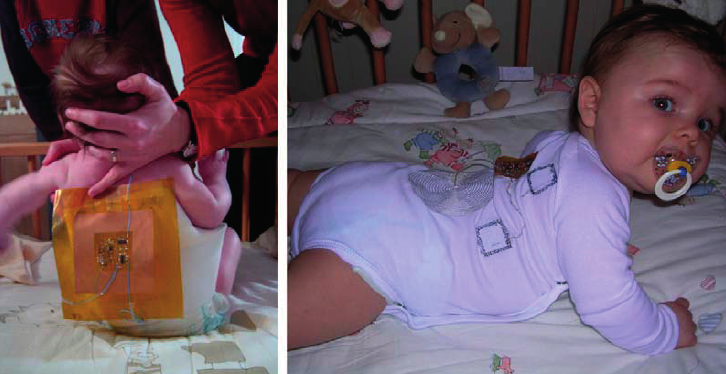
Figure 3. Left : demo set-up with belt prototype, worn by a 12-week-old baby; Right : baby